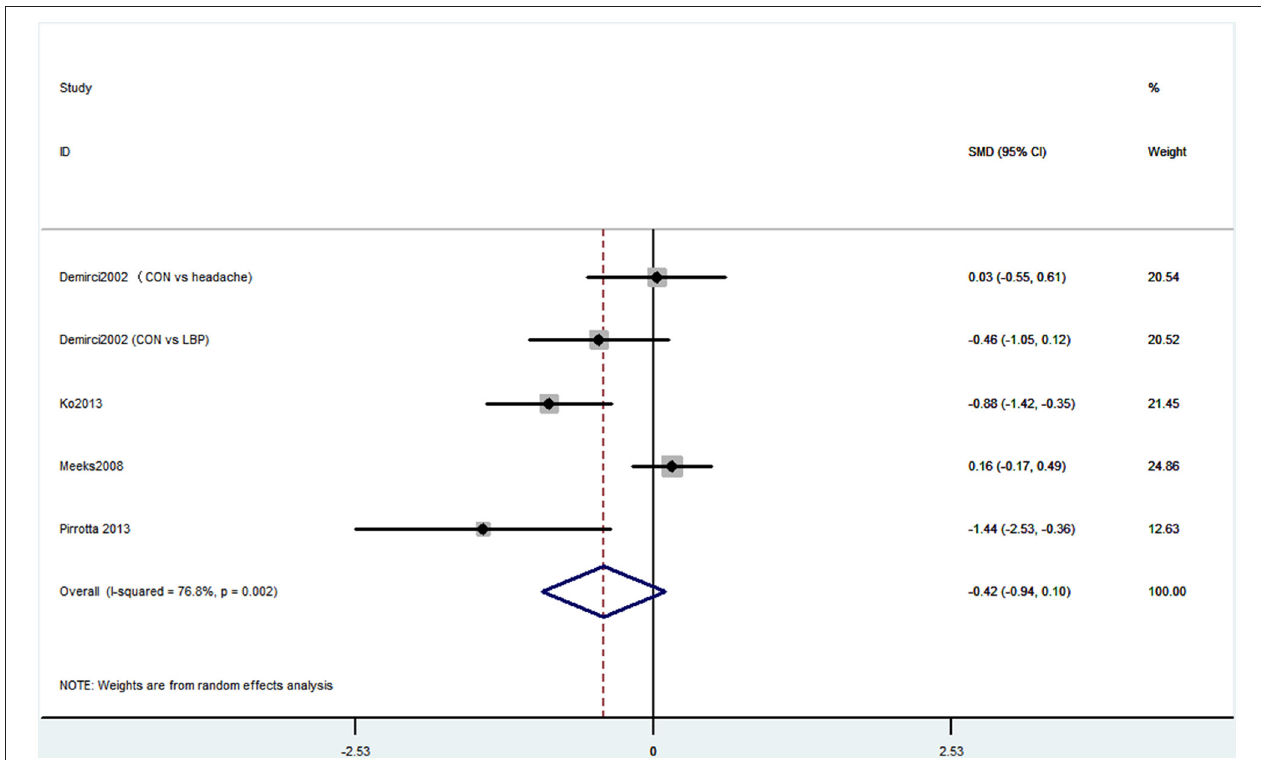
FIGURE 7 | Forest plot of the SMD and 95% CI from a random-effects meta-analysis for the association between chronic pain and incidence of cognitive decline when MMSE continuous score was used. The rhombi represent the pooled SMD for this association. CON, control group; LBP, low back